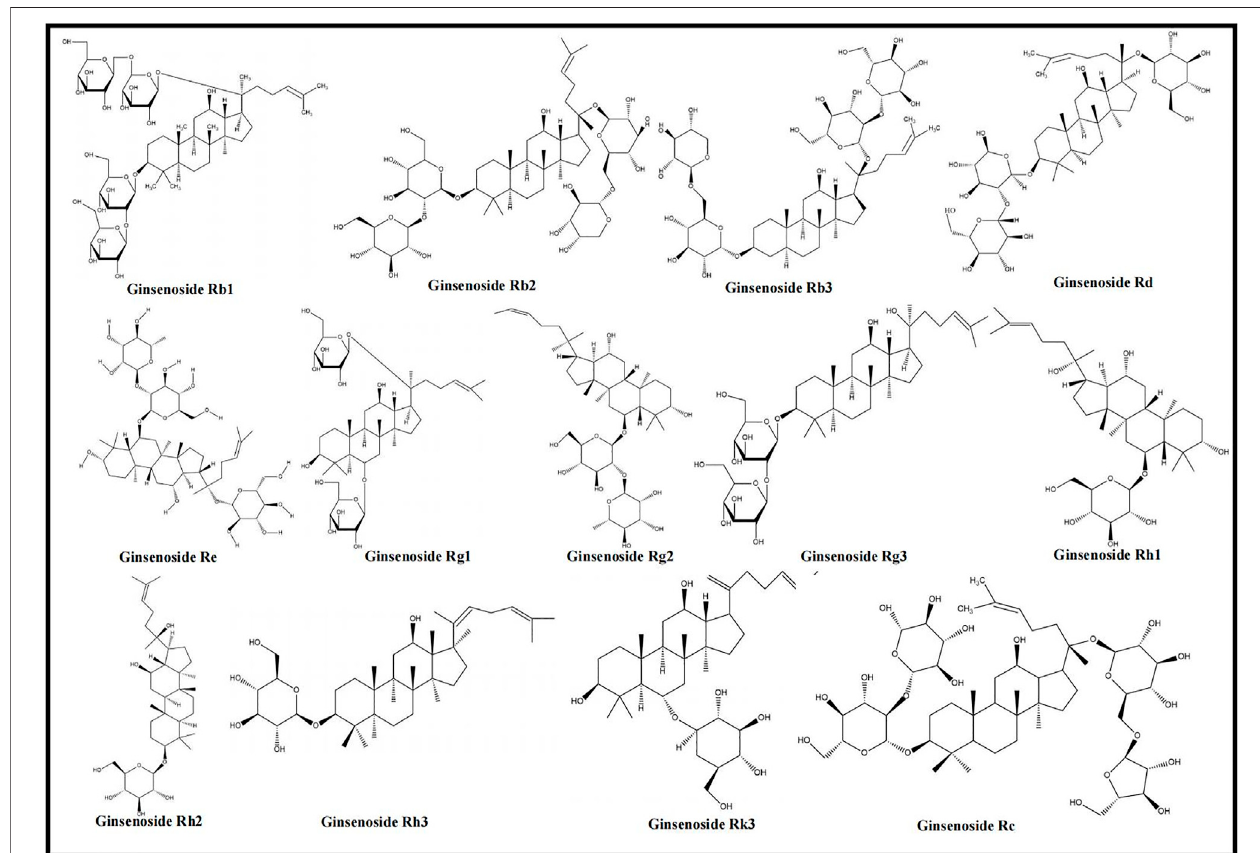
FIGURE 2 | Chemical structures of ginsenosides (ginsenosides Rb1, Rb2, Rb3, Rd, Re, Rg1, Rg2, Rg3, Rh1, Rh2, Rh3, Rk3, and Rc).